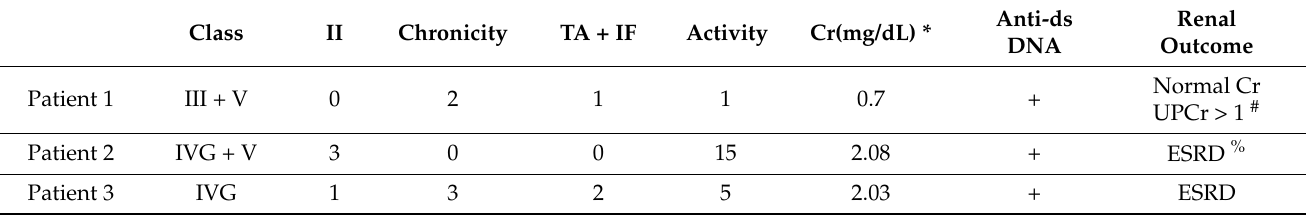
Table 4. Data of the three lupus nephritis patients for the Syndecan-1 stain.